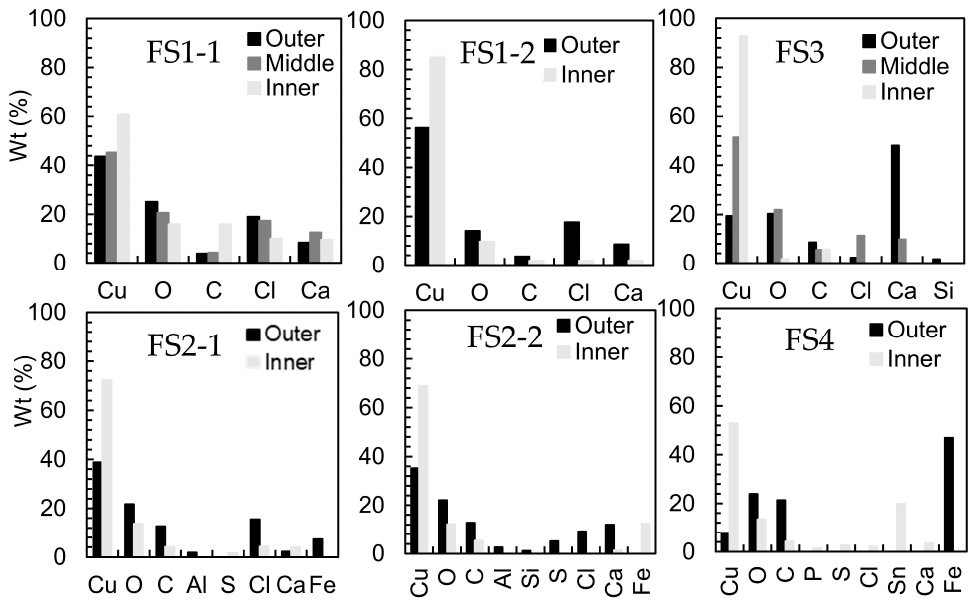
Figure 3. Elemental analysis via EDS on the surface of molten marks.